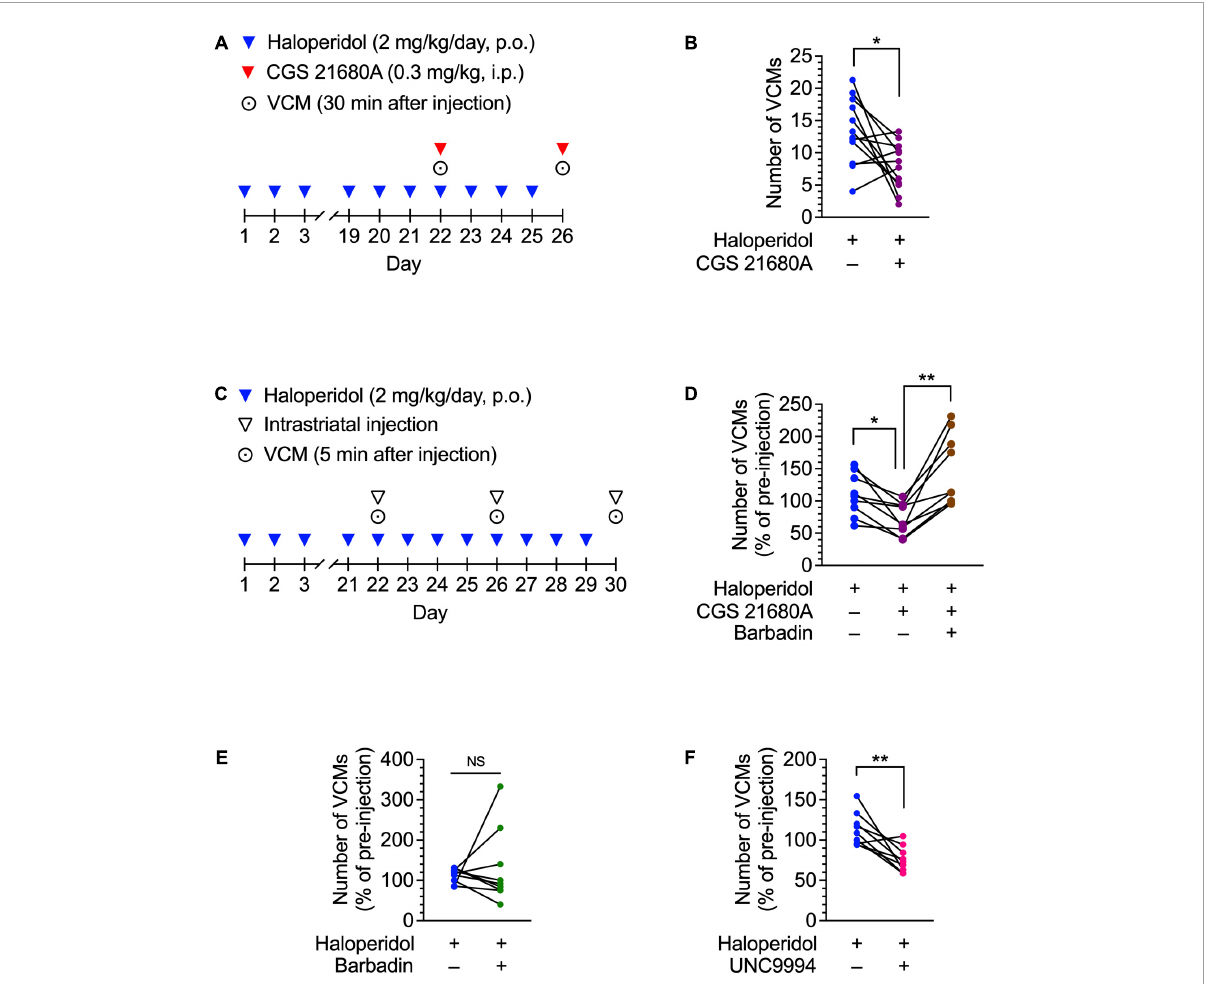
FIGURE2 Effects of CGS 21680A, barbadin, and UNC9994 on haloperidol-induced VCMs in mice. (A,B) Mice ( n = 12 per group) were administered oral haloperidol (2 mg/kg/day) daily for 21 days and then CGS 21680A (0.3 mg/kg, i.p.) at 24 h after the last administration of haloperidol. VCMs were counted for 3 min starting at 30 min after CGS 21680A or vehicle administration. Daily haloperidol treatment was continued for 4 more days; on day 26, a second set of VCM measurements were taken in a crossover design. Statistical significance was tested using two-tailed paired t -test. * P < 0.05. (C,D) Mice ( n = 9 per group) were orally administered haloperidol (2 mg/kg/day) daily for 21 days. On day 22, VCMs were counted for 5 min as an initial baseline before the mice received vehicle, CGS 21680A (1 ng/side), or CGS 21680A + barbadin (300 ng/side) through a pre-implanted cannula in their dorsal striatum. Five minutes after the injection, the VCMs were counted for another 5 min to determine the effect of the injected drug. Daily haloperidol treatment was continued for 8 more days; on day 26 and 30, the second and third sets of VCM measurements were taken in a crossover design. Changes in the number of VCMs for individual mice on days 22, 26, and 30 are represented as percentages of the pre-injection VCM count. Statistical significance was tested by performing repeated measures one-way ANOVA with a post hoc Tukey’s test. * P < 0.05; ** P < 0.01. (E,F) Mice ( n = 9 per group) were treated daily with orally administered haloperidol (2 mg/kg/day) for 21 days. On day 22, after the VCMs were counted for 5 min as an initial baseline, half of the mice received vehicle, and the rest received barbadin (300 ng/side) or UNC9994 (10 ng/side) through a pre-implanted cannula in their dorsal striatum. Five minutes later, the number of VCMs was counted for another 5 min to determine the effect of the injected drug. Daily haloperidol treatment was continued for 4 more days; on day 26, the second set of VCM measurements was taken in a crossover design. Changes in the number of VCMs are represented for individual mice on days 22 and 26 as percentages of the pre-injection VCM count. Statistical significance was tested using two-tailed paired t -test. ** P < 0.01; NS, not